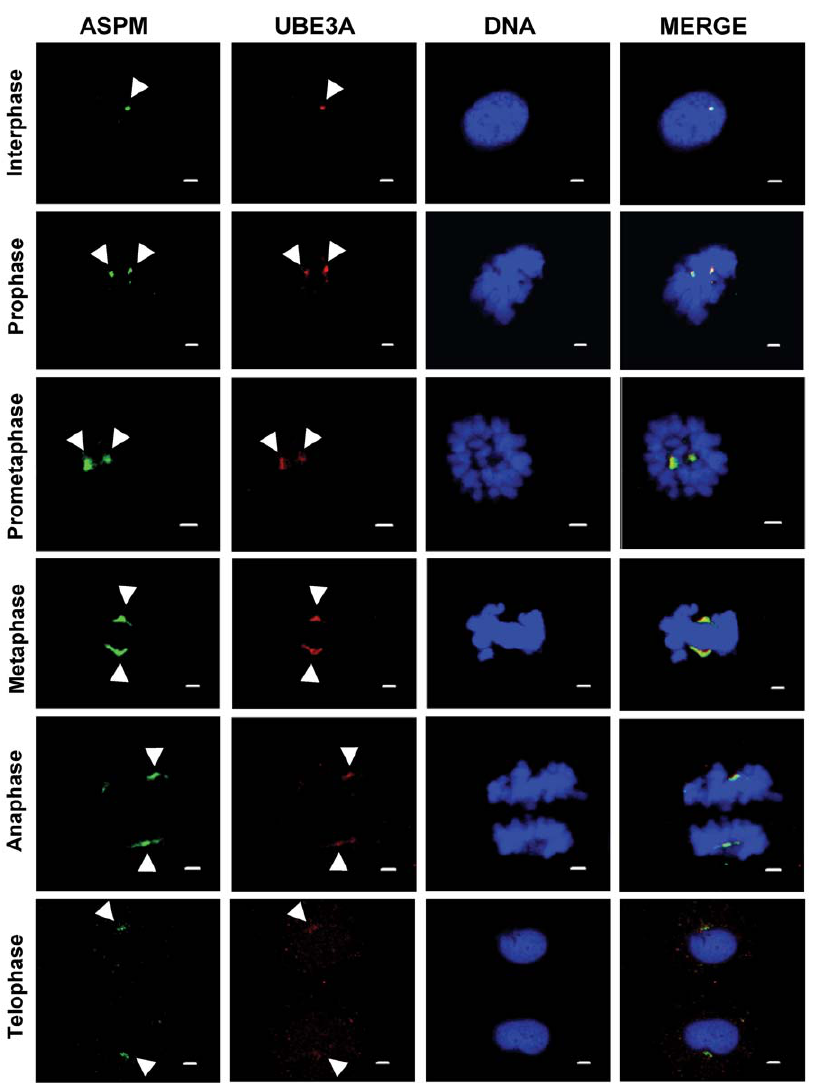
Figure 4. Confirmation of colocalization of UBE3A with ASPM at the centrosome using a different UBE3A antibody. Indirect immunofluorescence of HEK293 cells at interphase and different phases of mitosis stained with antibodies against ASPM and UBE3A (anti-UBE3A-sc- 12380). Note anti-UBE3A-sc-12380 antibody (arrowheads) also shows a centrosomal staining pattern as observed with anti-UBE3A-sc-8926 antibody. Scale bar=2 m